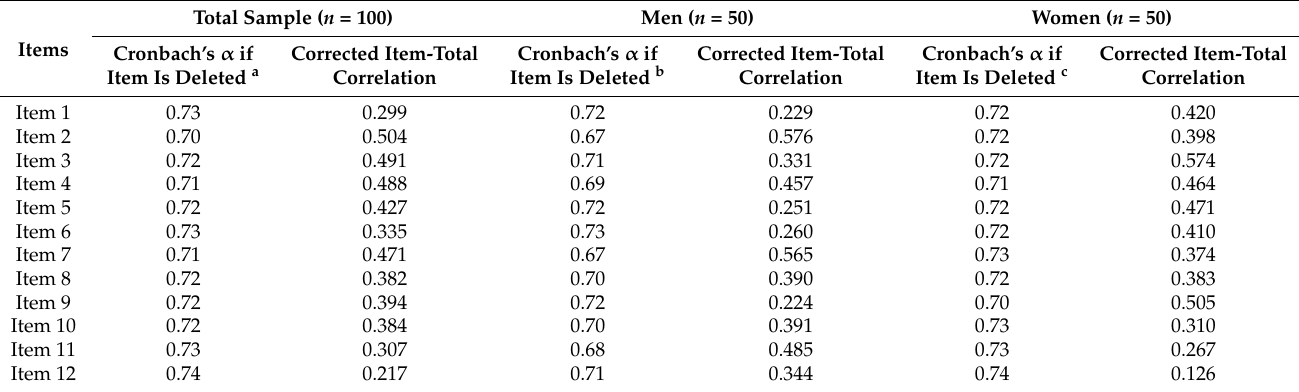
Table 3. Internal consistency and homogeneity values of the AAC-Q-ES in overall sample, men and women ( n =